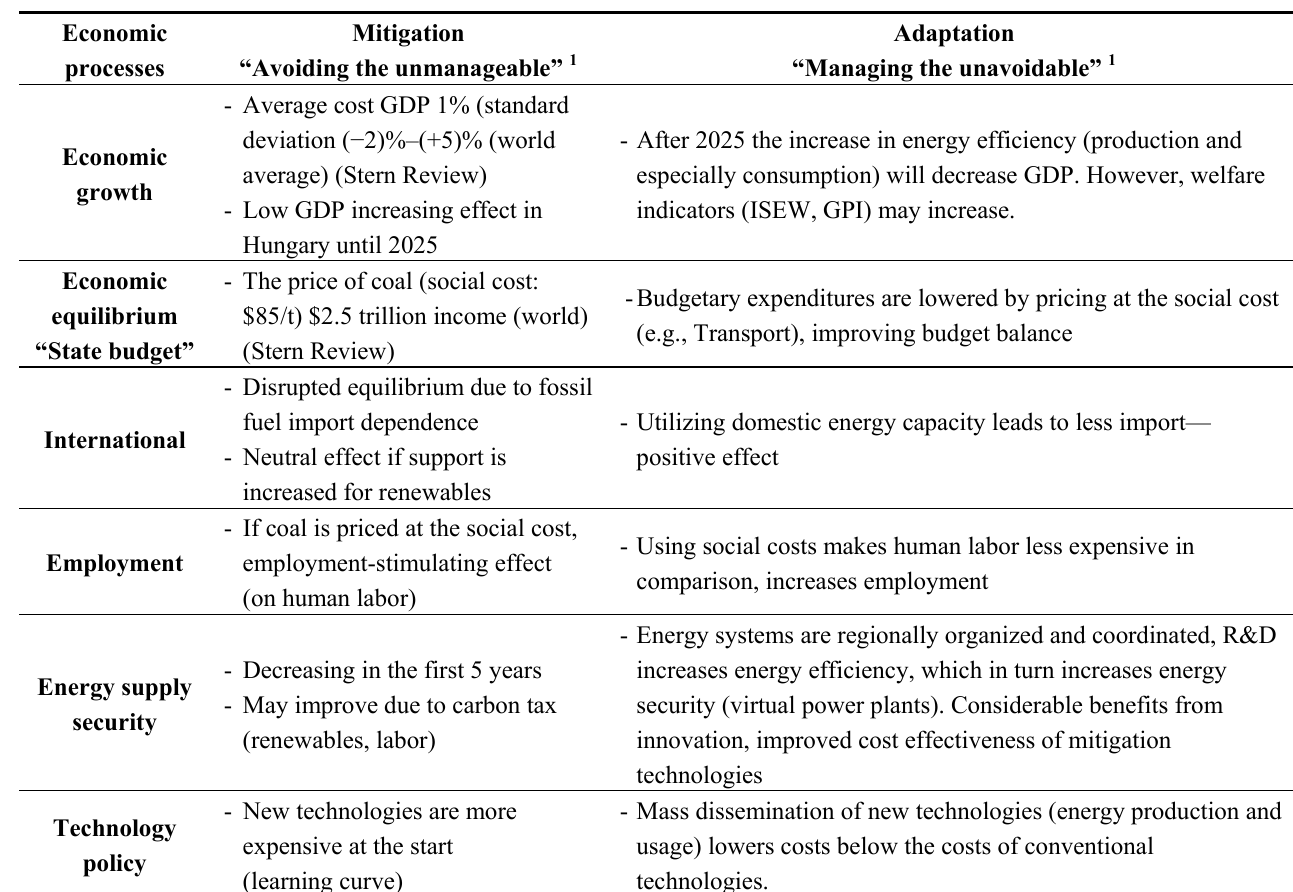
Table 4. Economic effects of GHG emission reduction and adaptation measures (Source: own